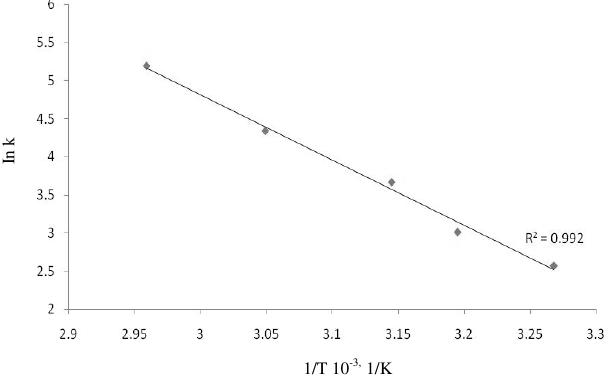
Figure 8. Van’t Hoff Plot for adsorption of RHD dye onto ZAWAC Table 4. Thermodynamics parameters for the adsorptive removal of RHD dye onto ZAWAC